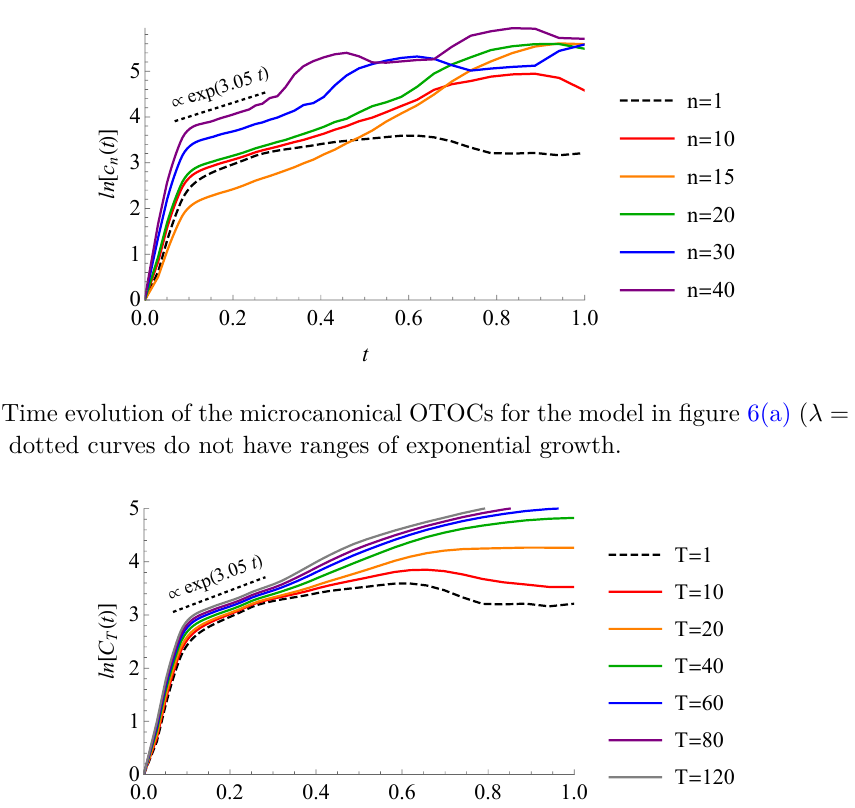
Figure 8 . Time evolution of the thermal OTOCs for the model in figure 6(a) ( λ = 2 The dotted curves do not have ranges of exponential